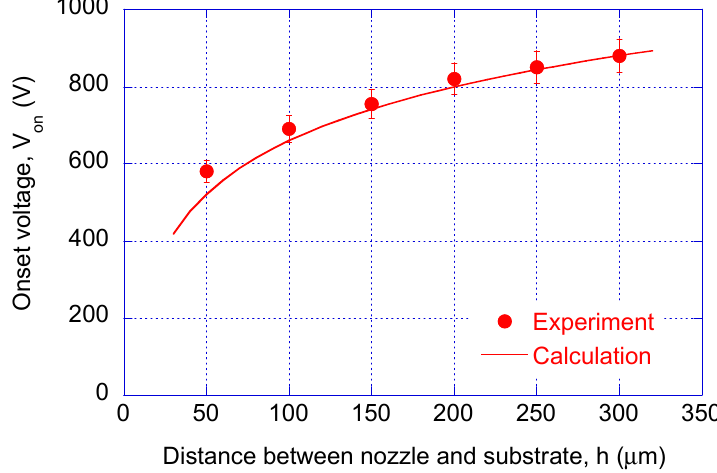
Figure 2. Onset voltage, V on , as a function of distance between nozzle and substrate. Calculated data is based on Equation (1), and experimental data were obtained using Nozzle A ( d n = 30 µ